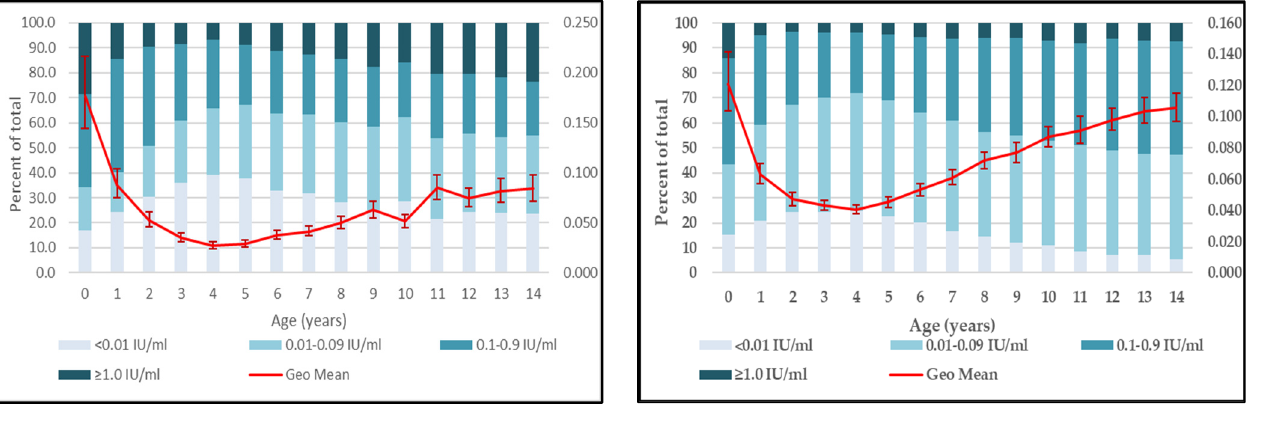
Figure 4. Tetanus and diphtheria seroprotection levels and geometric mean antibody level by age, Nigeria, 2018 ( a , b ). Nigeria, 2018 ( a , b ).